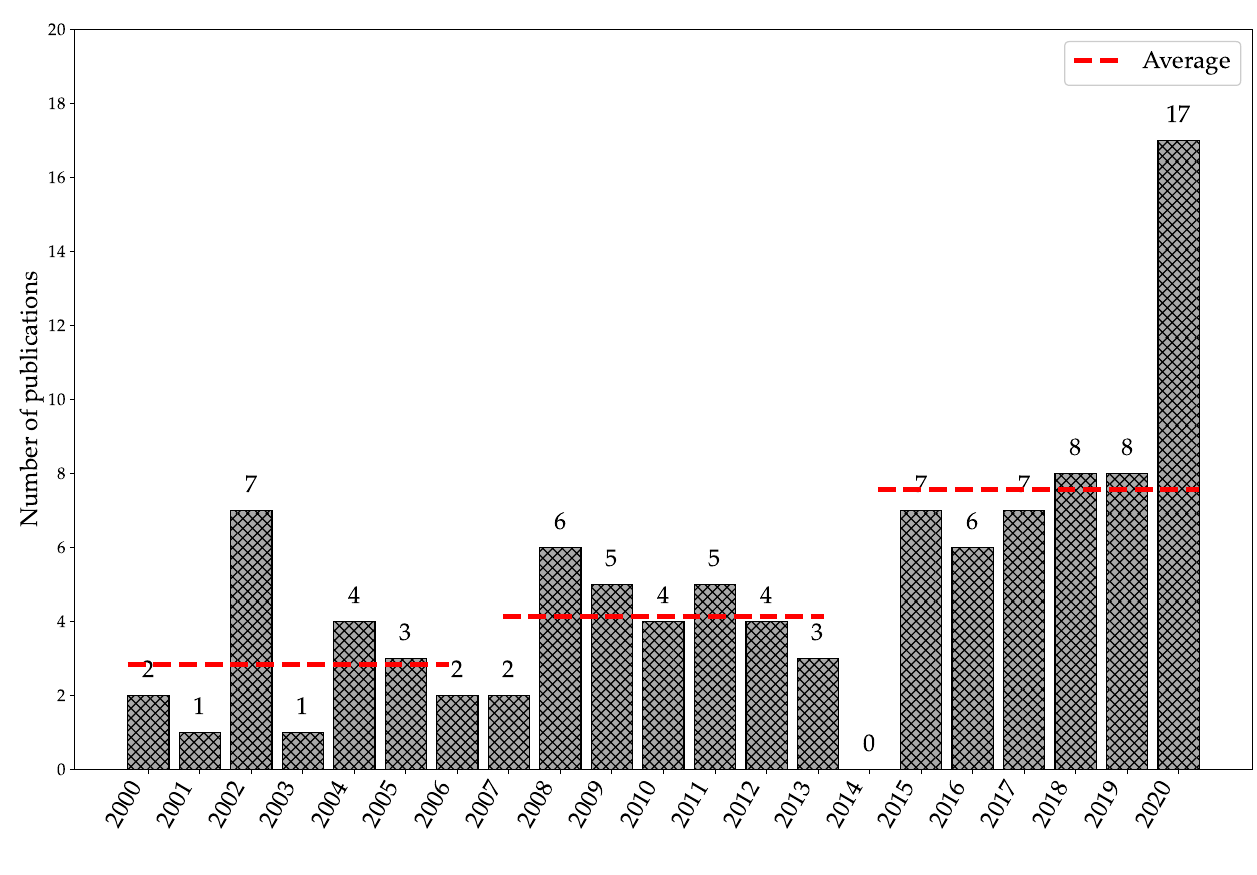
Figure 4. Number of publications per year in